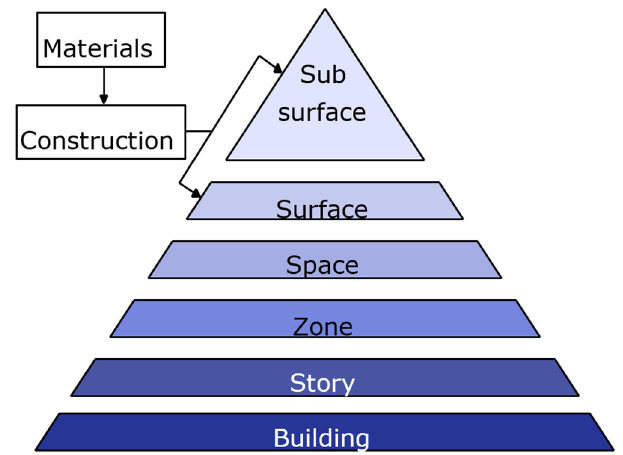
Figure 2. Hierarchy of the different geometry and HVAC abstractions in OpenStudio/EnergyPlus.